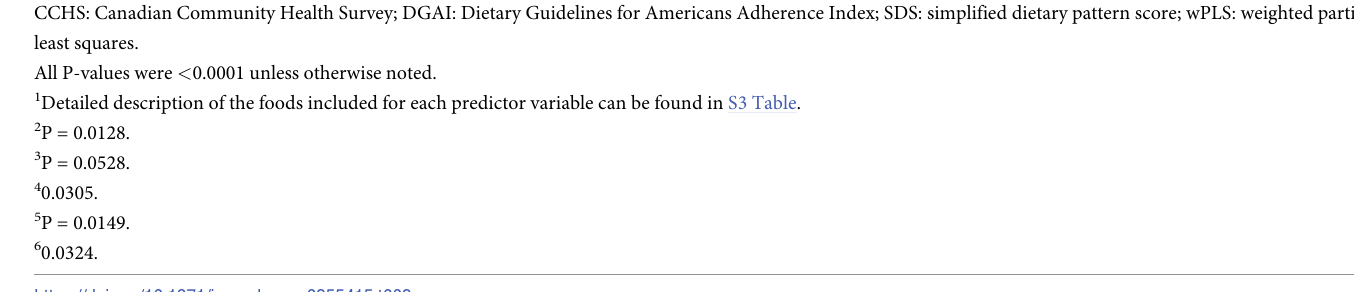
Table 4 depicts mean daily intake of the food/beverage predictors from the wPLS model which loaded significantly (i.e. loading factor � |0.17|) across quartile categories of the wPLS score